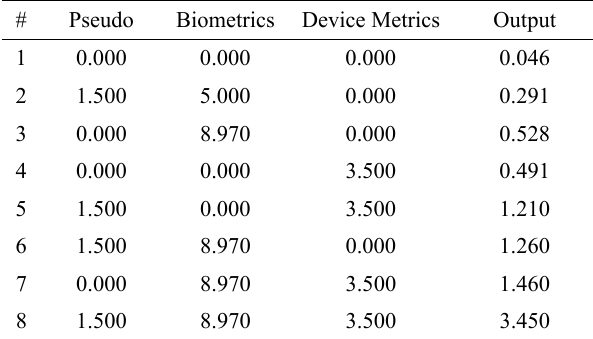
Table 9: Input values and the corresponding output values generated by the FIS information fusion technique using term weight identity attributes metrics values.